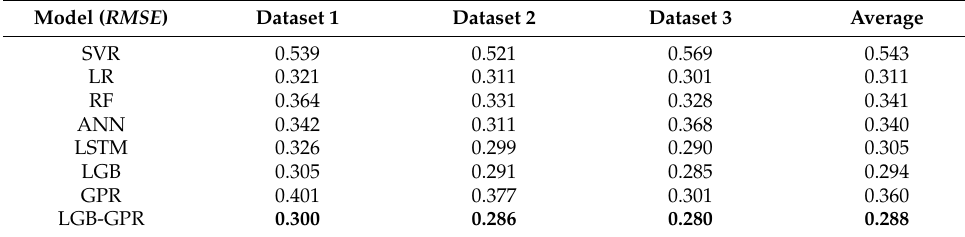
Table 3. RMSE score results statistics table.